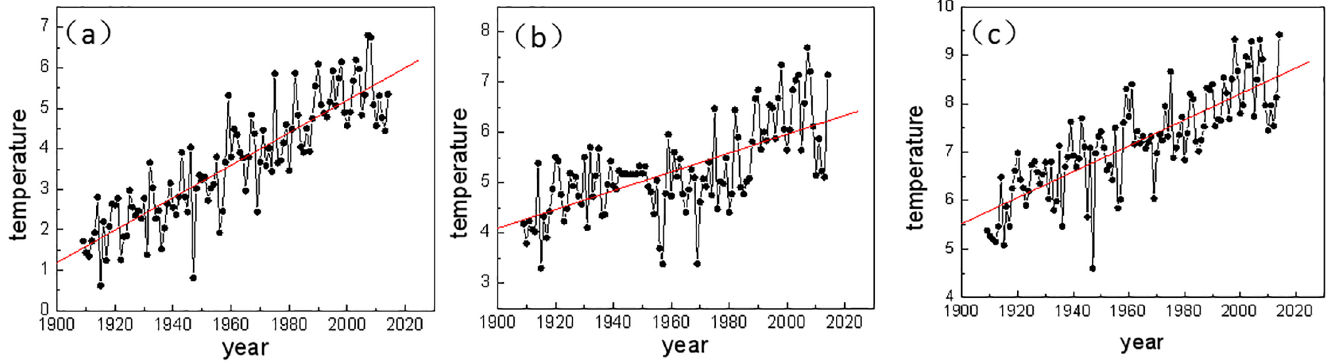
PLOS ONE | https://doi.org/10.1371/journal.pone.0198238 June 6,